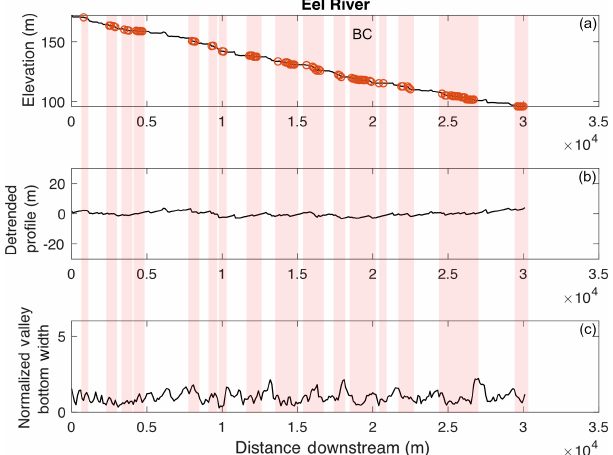
Figure 7. (a) Elevation long profile of the Eel River. Locations where the channel intersects mapped earthflows in Fig. 4 are shown in red. (b) Detrended elevation profile of the Eel River for the reach shown in panel (a) . (c) Valley bottom width on the Eel River nor- malized by the mean valley bottom width over the reach shown in panel (a) . Red rectangles highlight earthflow-impacted reaches in panels (a) – (c) . BC indicates location of Boulder Creek